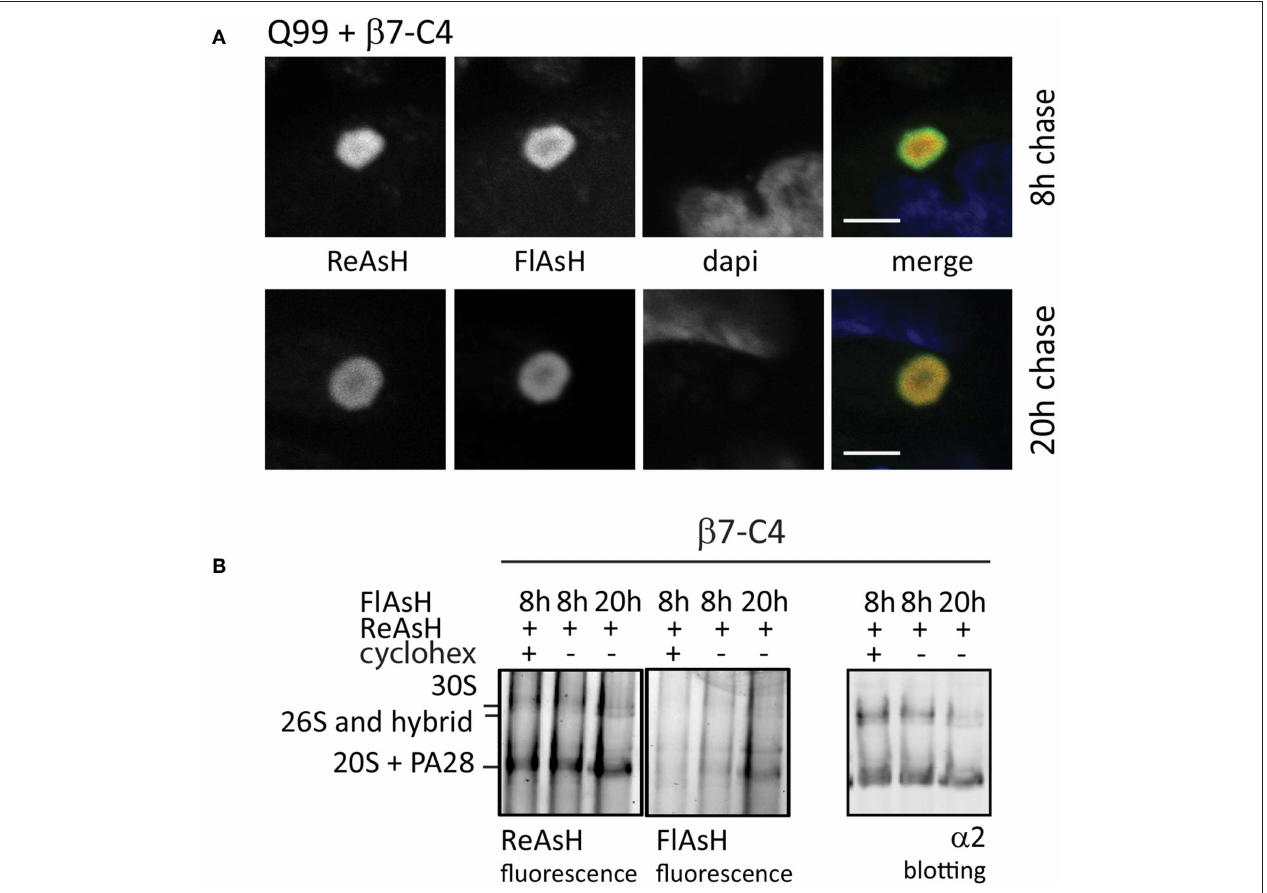
FIGURE 7 | Fluorescence pulse-chase experiments to visualize proteasome dynamics. (A) Reversible recruitment of proteasomes into aggregates. HeLa cells were transfected with untagged Q99 peptides to initiate aggregation and co-transfected with proteasome subunit β 7-C4 to visualize proteasomes. After 48h expression, β 7-C4 was stained with ReAsH followed by FlAsH labeling 8 or 20h to specifically label the newly synthesized pool of proteasomes. Merging of the fluorescent proteasome labeling showed a partial overlap at 8h (upper panel) and a complete overlap at 20h afterwards (lower panel). These findings indicate that proteasomes have slow but reversible dynamics in aggregates. (B) Specific proteasome labeling by biarsenical dyes. Cells expressing β 7-C4 were stained according to the same procedure a mentioned above. Additionally, cycloheximide was added after ReAsh staining to prevent synthesis of new C4-tagged proteasome subunits. After FlAsH staining, cells were harvested and subjected to a 3–12% native gel for complexes separation and subsequently scanned for fluorescence. Specific proteasome labeling by both ReAsH and FlAsH was confirmed since these complexes run similar to proteasome complexes that were probed with an α 2-antibody. FlAsH staining intensified when labeling was performed after a longer chase period due to longer expression. When cycloheximide was added, FlAsH labeling was absent. Scale bar = 2 µ